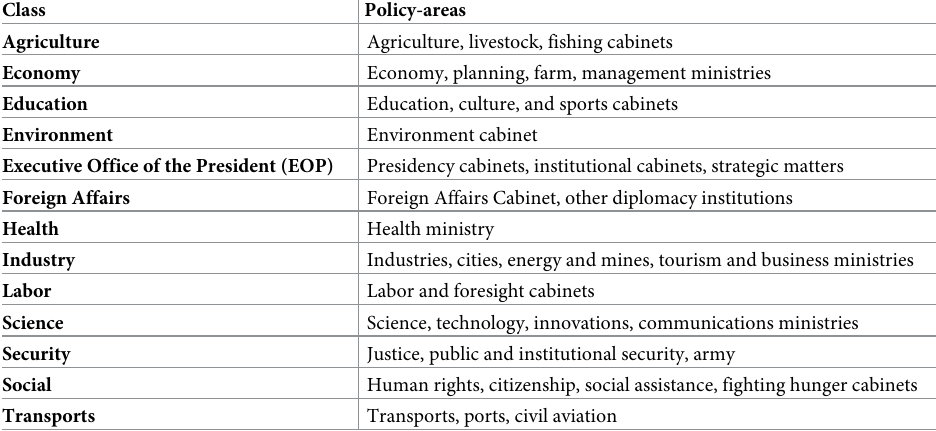
Table 4. Cabinets-based taxonomy